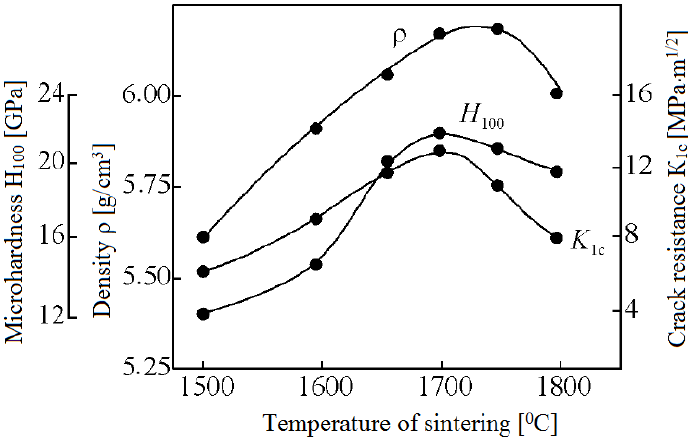
Figure 29. Microhardness Н sintered in the ammonia plasma of a glow